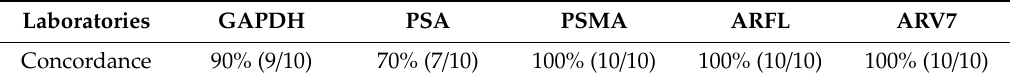
Table 2. Adna ARV7 Test concordance between two independent laboratories. Sample set consisted of five healthy donor and five spiked-in samples containing five LNCaP 95 cells each. Numbers in brackets indicate replicates (number of samples with concordant results / total number of samples).